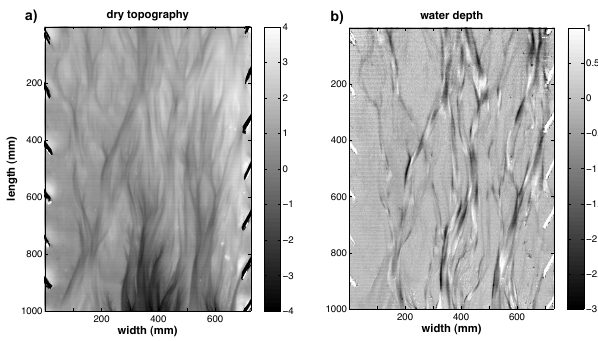
Fig. 6. (a) Bed topography obtained by switching of water flow and (b) water